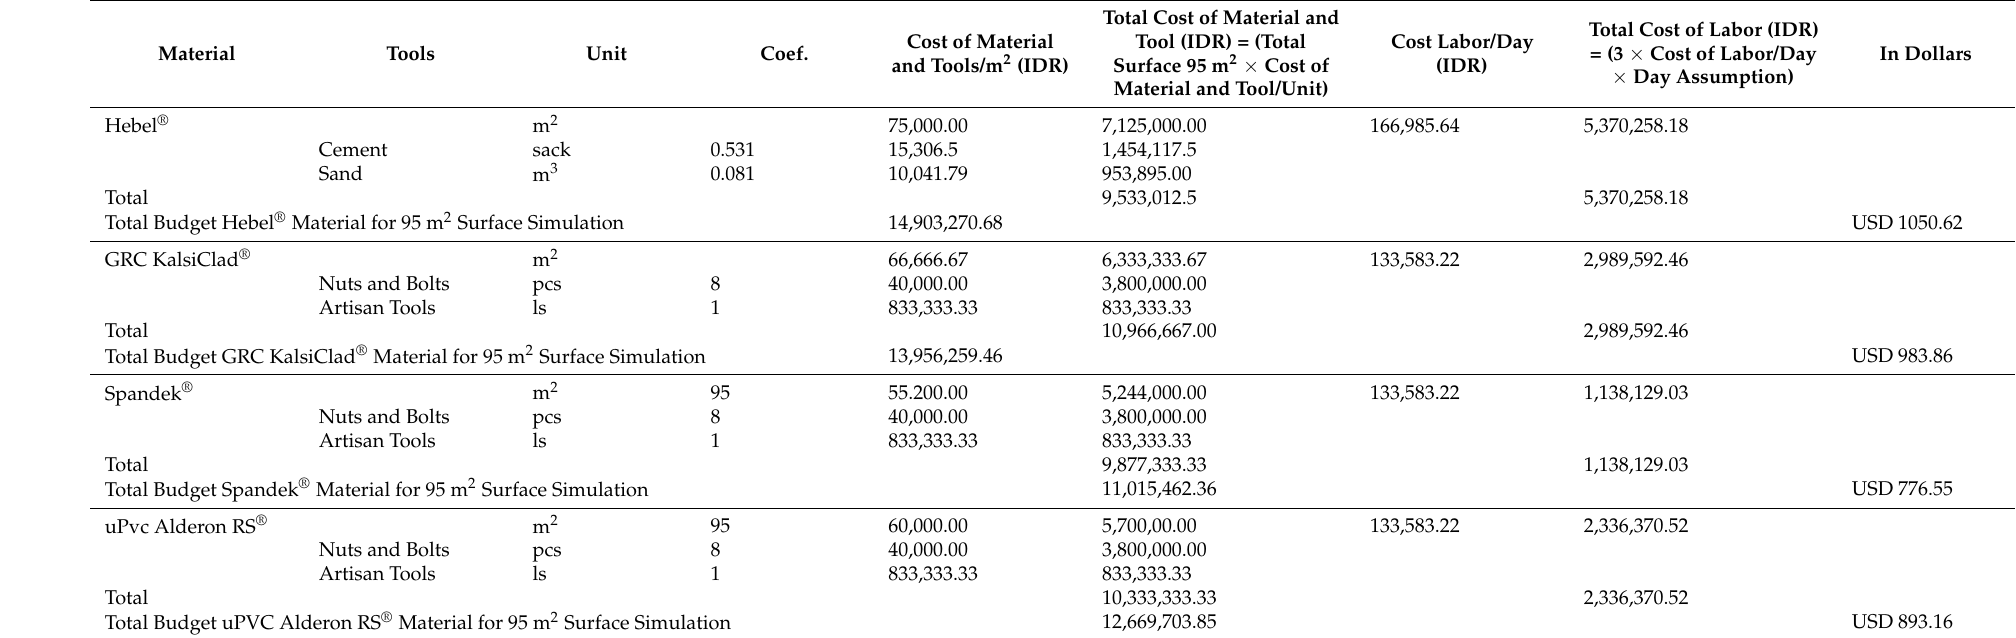
Table 5. Materials cost